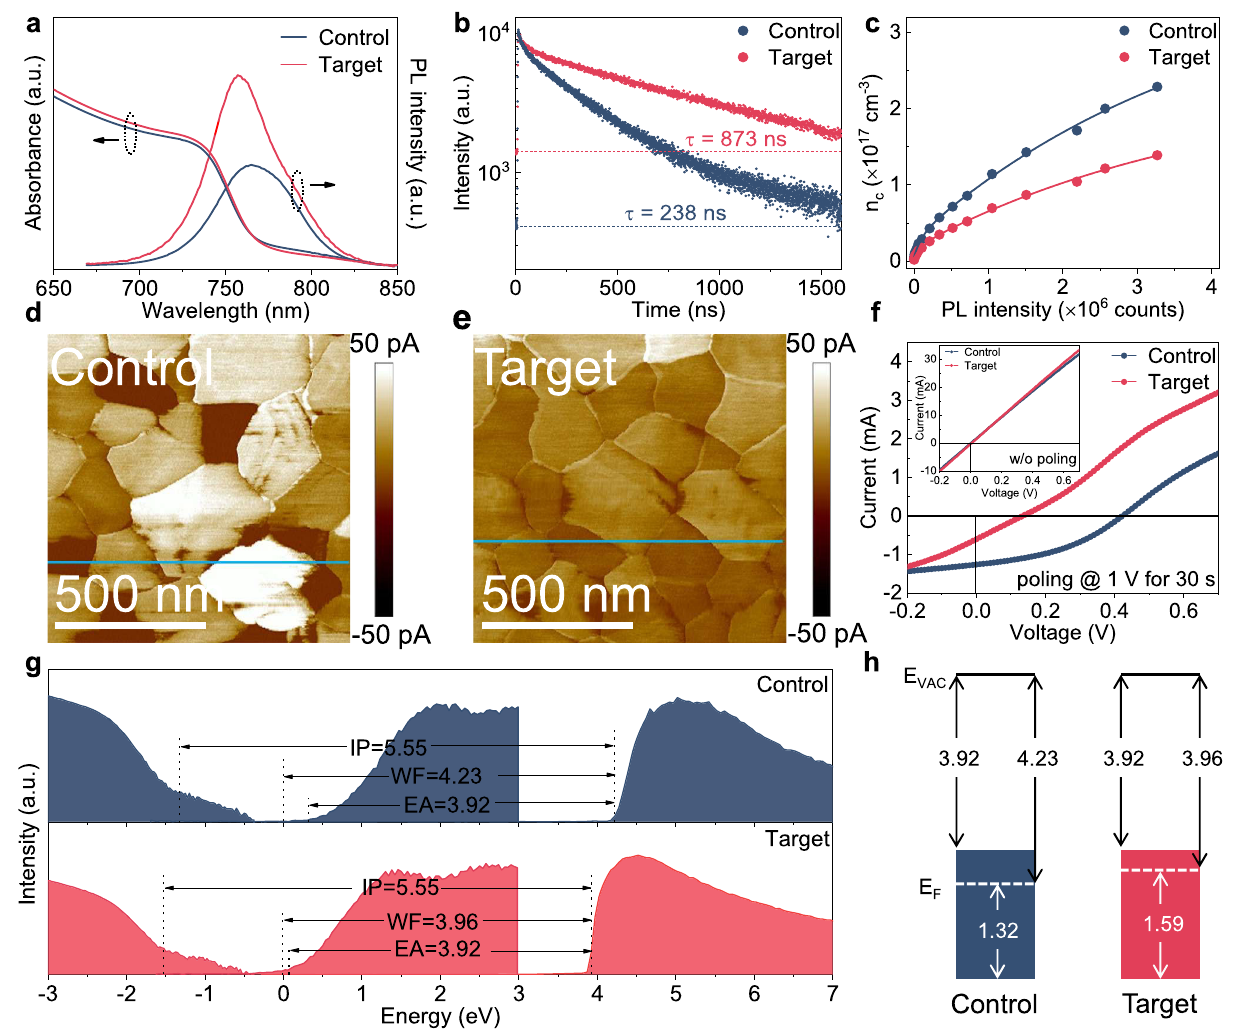
Fig. 3 | Properties of LAS-modi fi ed perovskite fi lms. a UV-vis absorption and SSPL spectra of perovskite fi lm without additives (referred as control) and [C 4 mim] + [C 8 SO 4 ] − treatedperovskite fi lms(referredastarget). b TRPLdecaycurves ofcontrolandtarget fi lms.Thedashedlinesindicatethebackgroundlevels. c Pump fl uence dependent PL measurements of control and target fi lms. The solid lines